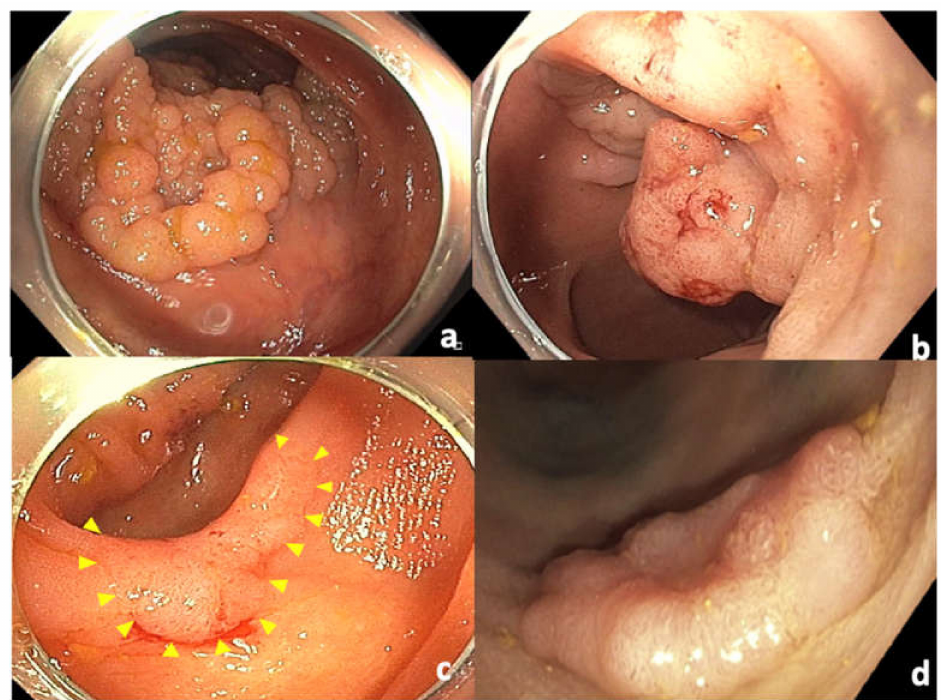
Figure 3. Classification of laterally spreading tumors. ( a ) Homogeneous granular laterally spread- ing tumor (LST-G); ( b ) nodular mixed type granular laterally spreading tumor (LST-MG); ( c ) flat nongranular laterally spreading tumor (LST-NG); ( d ) pseudodepressed nongranular laterally spread- ing